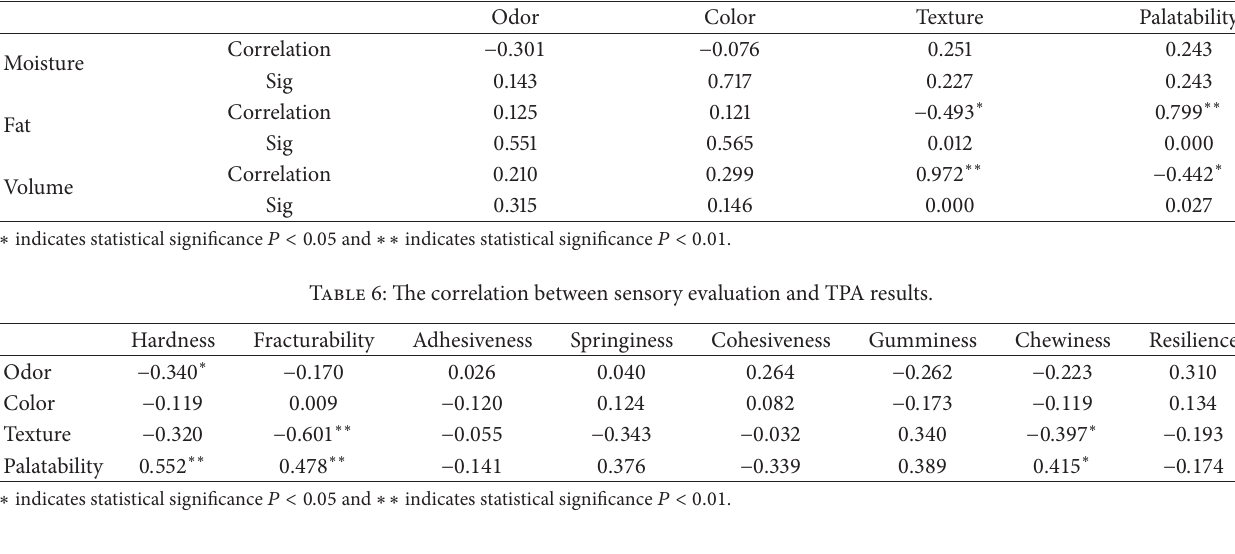
Table 5: The correlation between sensory evaluation and physicochemical indexes.